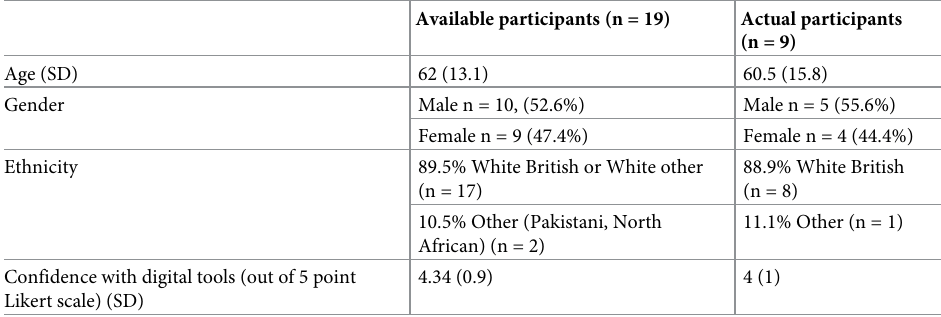
Table 1. Baseline characteristics of study